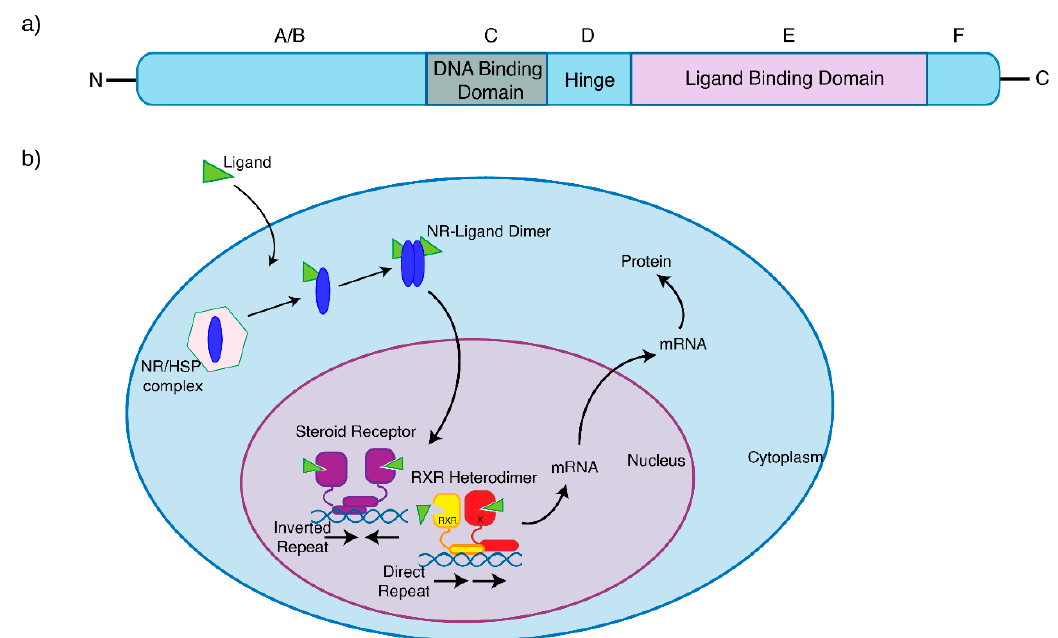
Figure 1. Nuclear receptors share the similar structural domains. ( a ) Most NRs contain an N-terminal region (A/B), a conserved DNA-binding domain (C), a variable hinge (D), a conserved ligand-binding domain (E), and a variable C-terminal region (F). ( b ) The NRs involved in breast cancer are bound to heat-shock proteins (HSP) in the cytoplasm, and are activated by binding of ligands, whereby canonical signalling is initiated. This NR–ligand complex will either form a heterodimer (steroid receptors), or form an RXR heterodimer, and translocate to the nucleus, binding to target genes and initiating transcription.